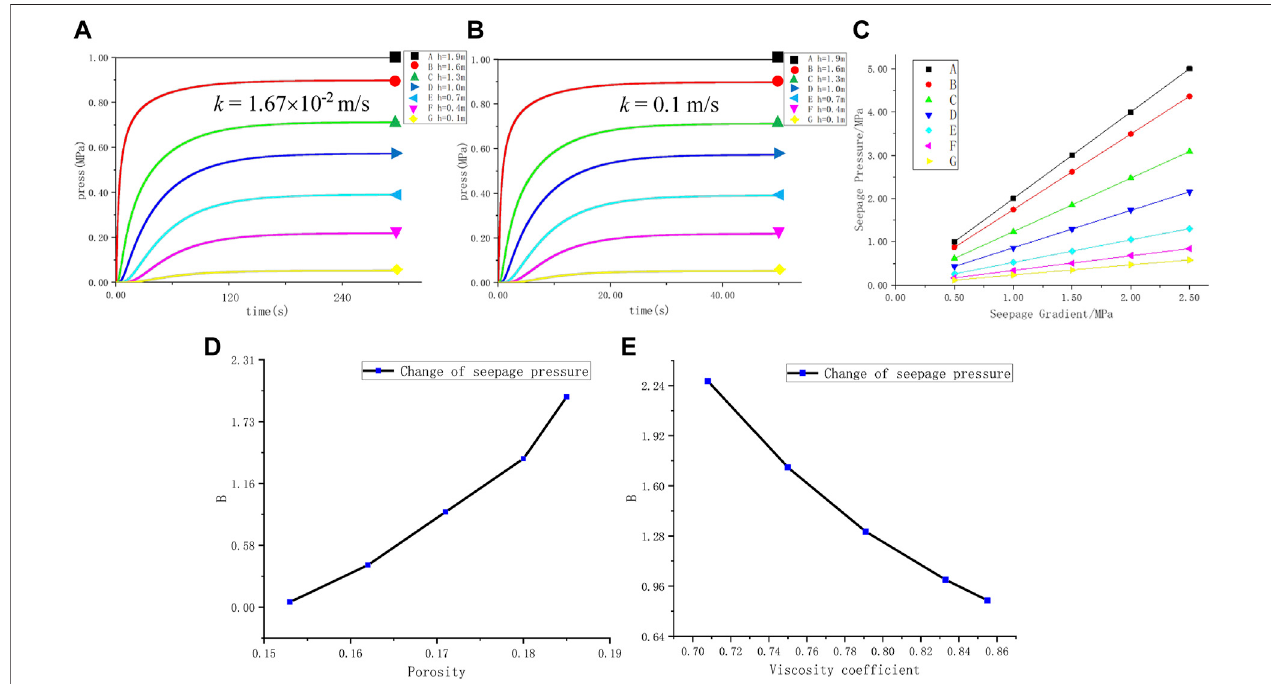
FIGURE3| Variationcurveofseepagepressure. (A) and (B) areseepagepressurecurvesatdifferentmeasurementpointsunderdifferentpermeabilitycoef fi cients, (C) is the variation curves of seepage pressure with seepage gradient in steady state, (D) and (E) are the parameter sensitivity analysis of the porosity and viscosity coef fi cient of the model to the growth rate of seepage pressure of the model.